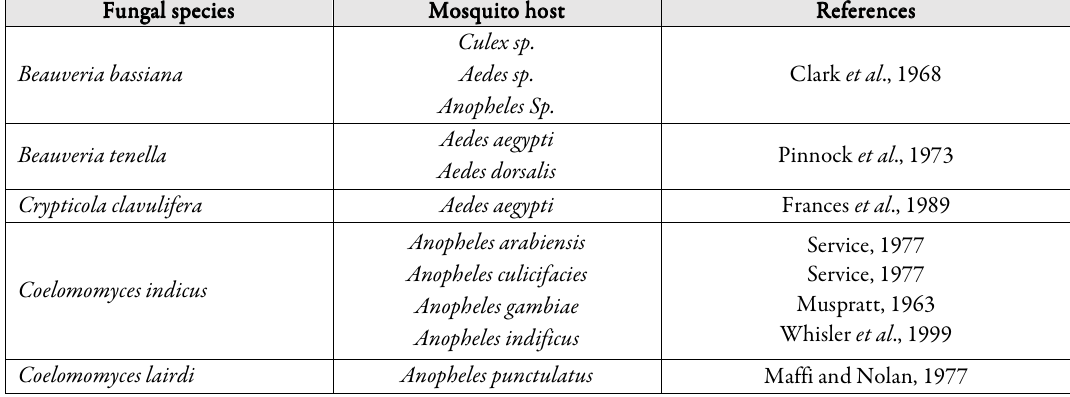
Table 3. List of fungal species reported against mosquito